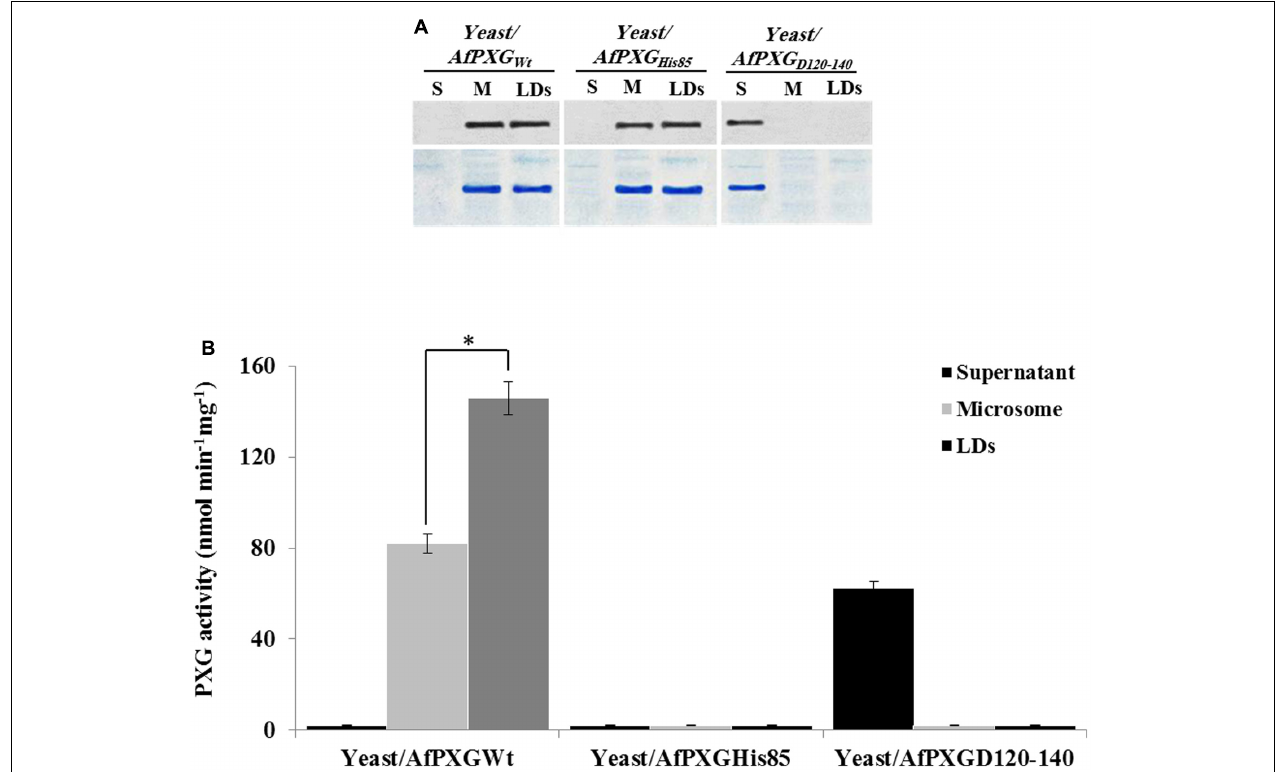
FIGURE 6 | Expression, subcellular localization and enzymatic activity of AfPXG variants. (A) Immunodetection of the mutated proteins AfPXG His85 and AfPXG D126 − 140 or native AfPXG WT in different subcellular fractions, supernatant (S), microsomes (M), and lipid droplets (LDs) isolated from the recombinant yeast. An antibody anti-PXG was used at dilution of 1:500. A horseradish peroxidase-conjugated anti mouse IgG diluted 1:2000, served as the secondary antibody. Loading control are gels stained with Coomassie Brilliant Blue. (B) Evaluation of the PXG activity (hydroxylation of aniline) in the respective subcellular fraction isolated from the recombinant yeast/AfPXG His85 , yeast/AfPXG D126 - 140 and yeast/AfPXG WT . All measurements were done in triplicate. Values are the means ± SD ( n = 3). The differences in PXG activity between microsomes and LDs were significant ( ∗ P <